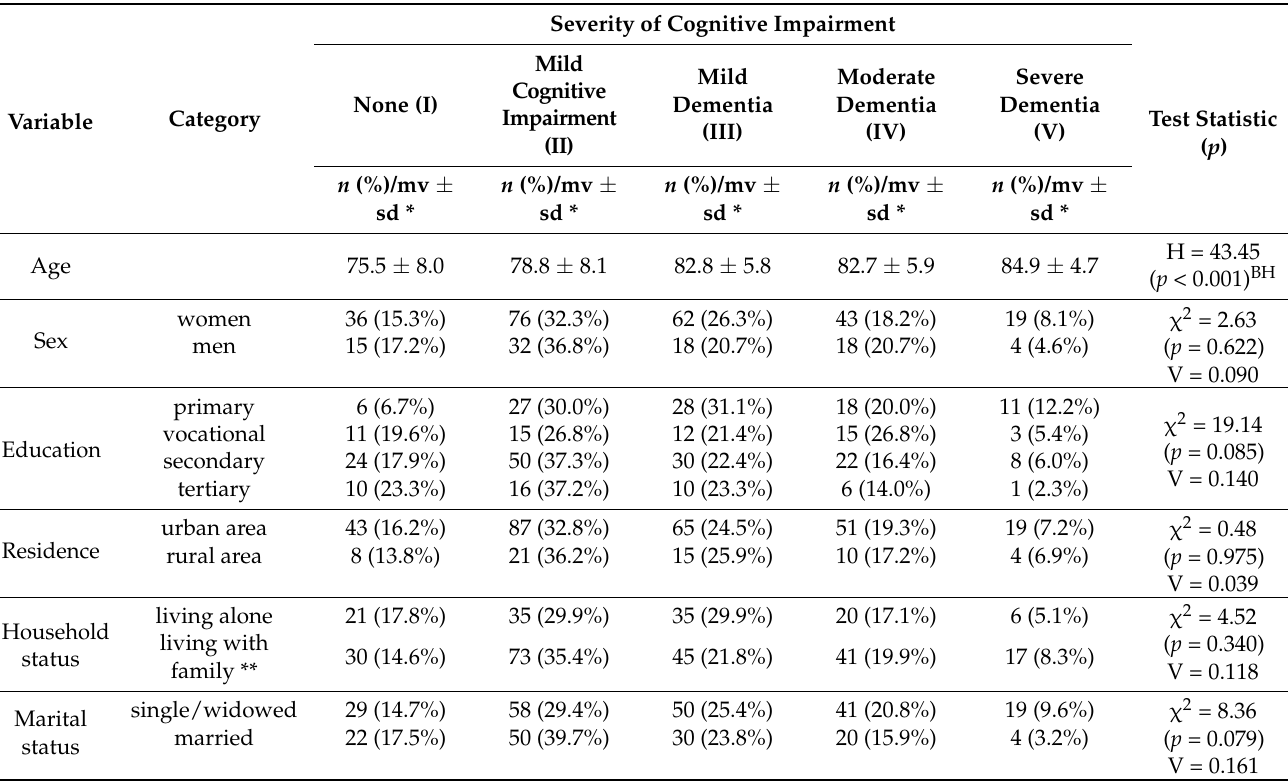
Table 2. Associations between sociodemographic factors and severity of cognitive